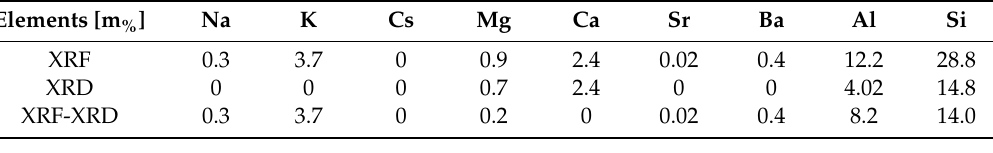
Table 3. Mass percentage of elements measured with XRF (m %XRF , first row), mass percentage of